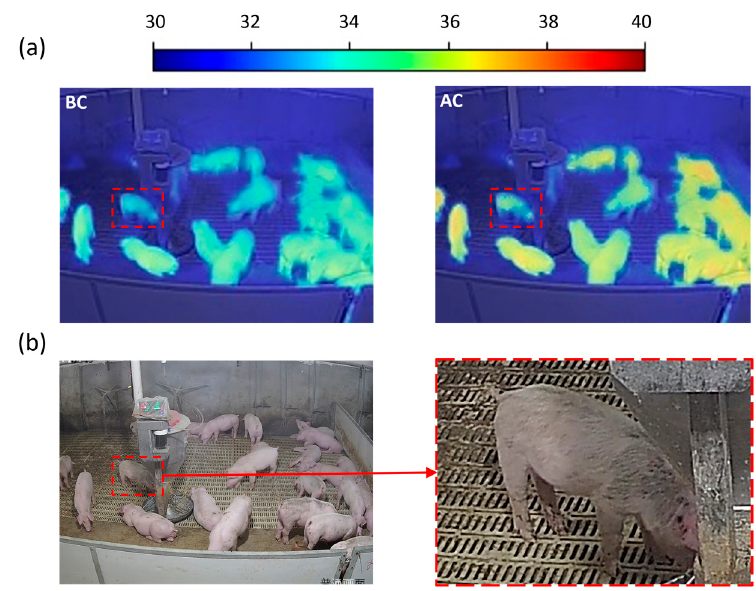
Figure 7. Infrared images ( a ) and visible image ( b ) of a pig pen.